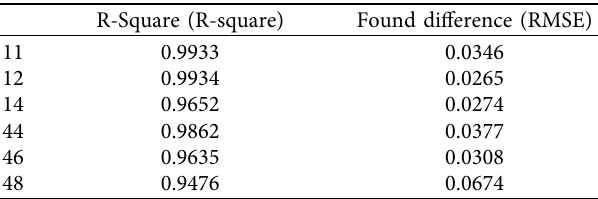
Table 3: Root mean square and variance of function fitting for each oil paint